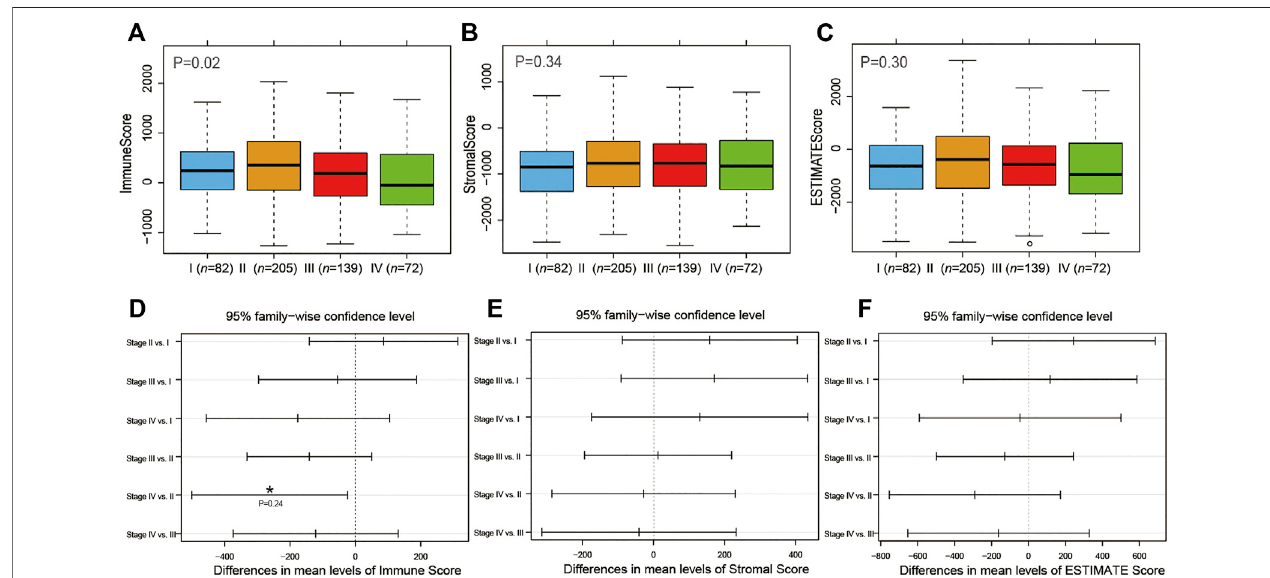
FIGURE 2 | Association of tumor stage with immune (A) , stromal (B) , and ESTIMATE (C) scores. Tukey ’ s HSD test to compare the differences between different tumor stages with immune (D) , stromal (E) , and ESTIMATE (F) scores.